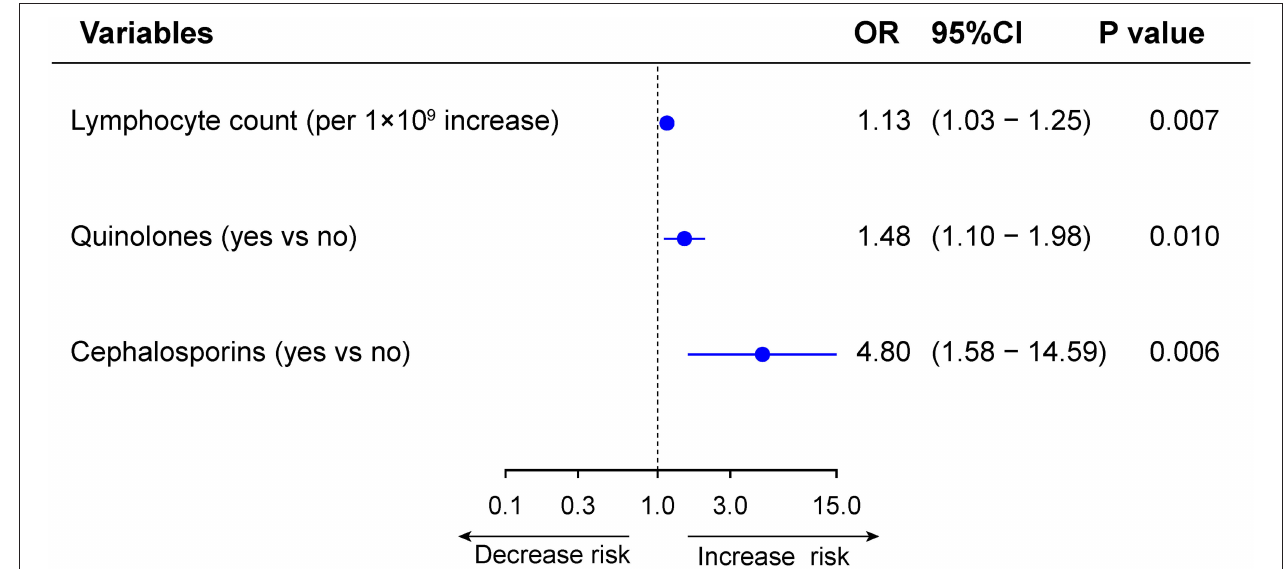
FIGURE 9 | Multivariable analysis of factors associated with de novo abnormal vs. normal liver function tests (LFTs) during